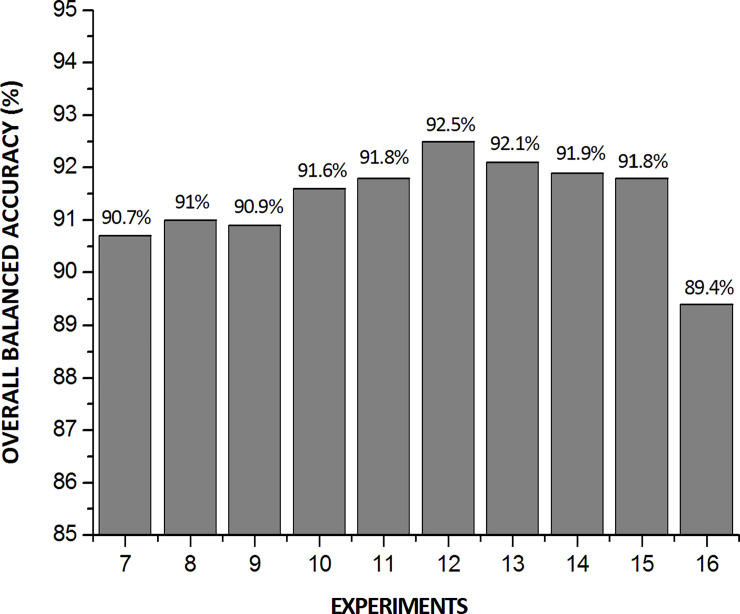
Overall BA of experiments 7–16 of Table 9.